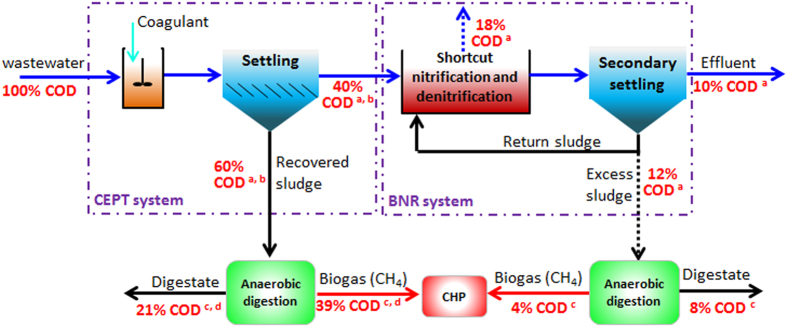
COD flow in A-B process with CEPT as A-stage and shortcut nitrification and denitrification as B-stage; (a) data from Metcalf and Eddy12; (b) data from Morrissey and Harleman13; (c) data from Parkin and Owen47; (d) data from Miron et al.48.